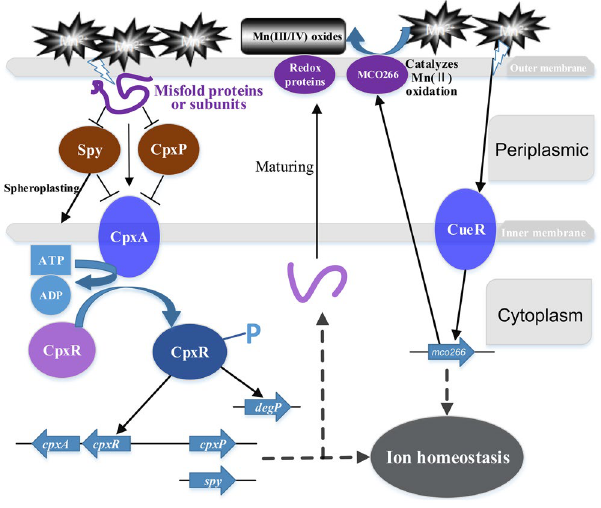
Figure 6. Predicted signal transduction mechanism associated with Mn oxidation and the stress